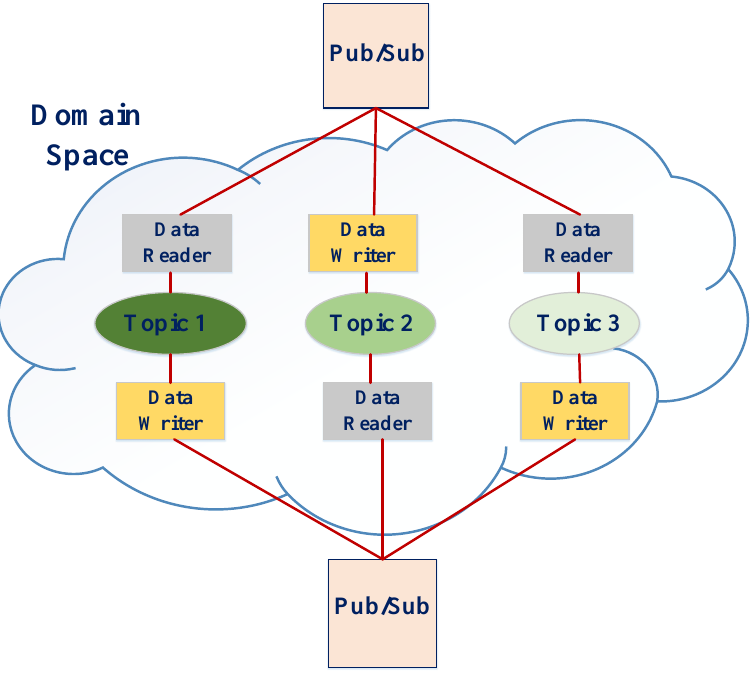
Figure 6. DDS domain